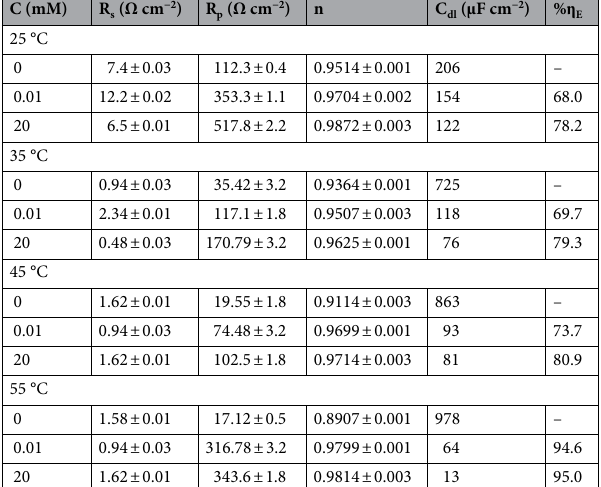
Table 4. Electrochemical impedance characteristics for MS at different temperatures in 5% HCl solution in the absence and presence of varying concentrations of expired Ampicillin drug. “ ± ” shows the standard deviation of three